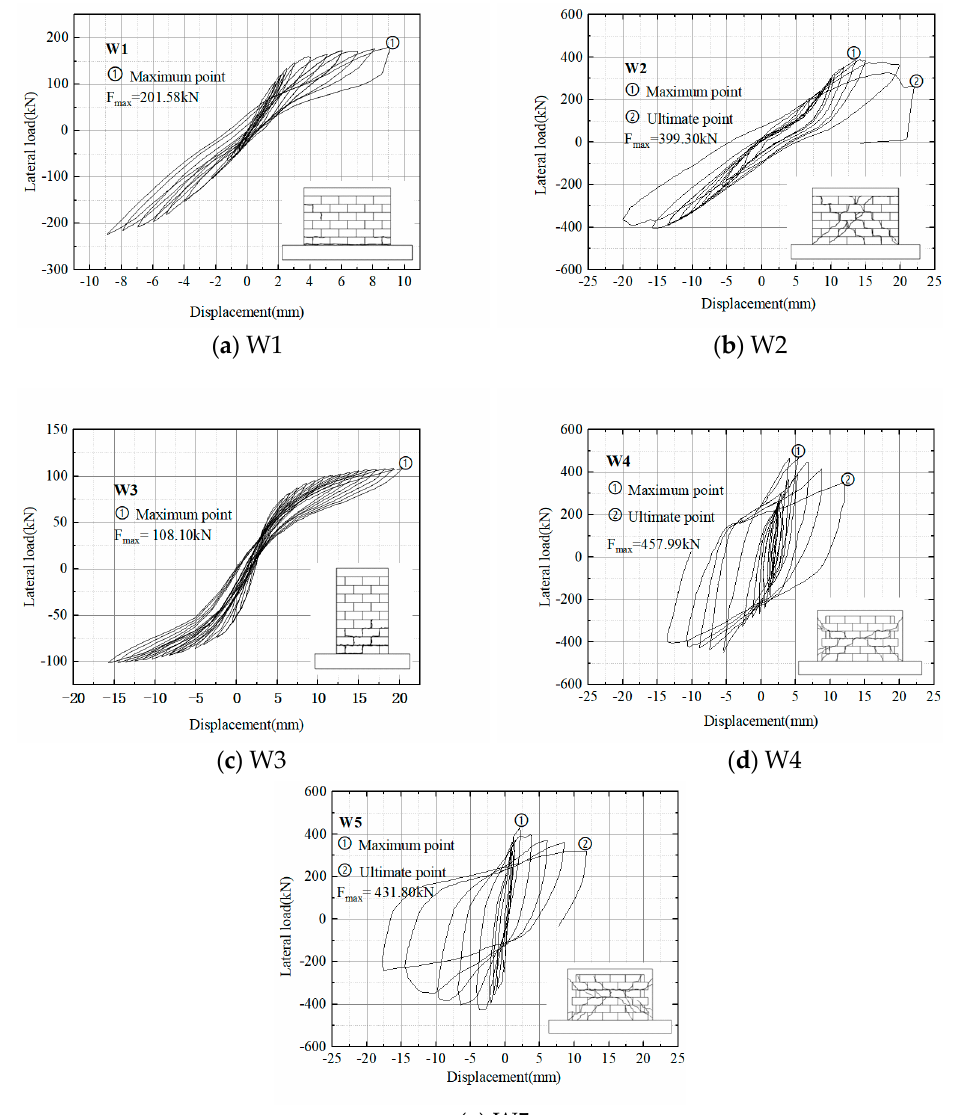
Figure 9. Hysteretic curves of five specimens: ( a ) W1; ( b ) W2; ( c ) W3; ( d ) W4; ( e ) W5.